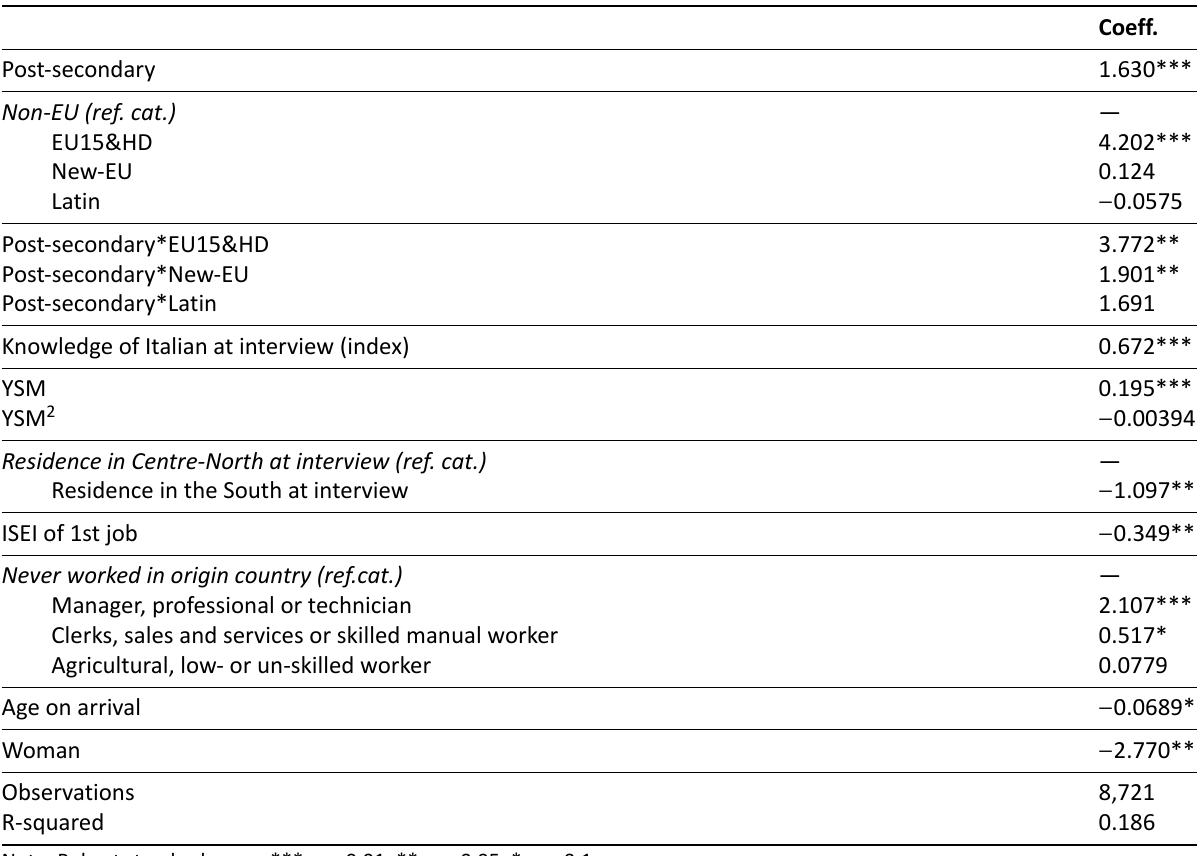
Table 2. Factors affecting upward mobility in Italy ( Δ ISEI